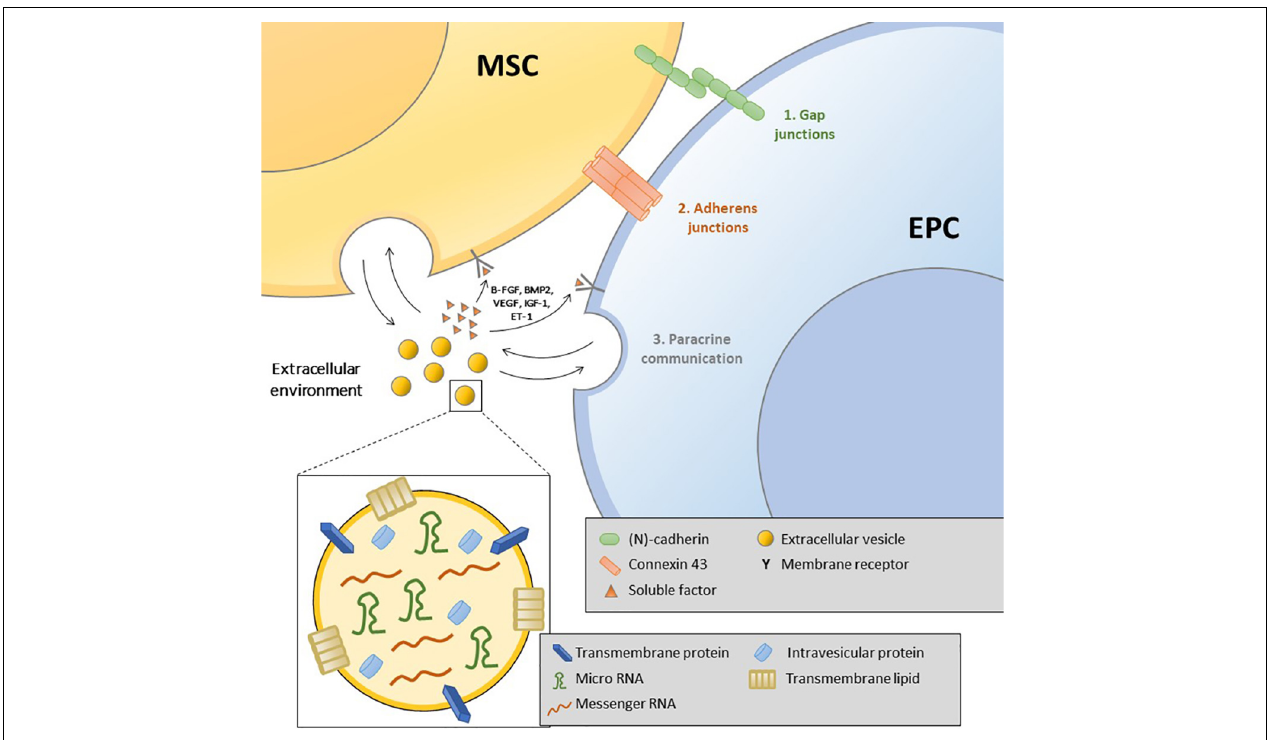
FIGURE 2 | Illustration of the different types of interaction between mesenchymal stromal cells and endothelial progenitor cells: gap junctions, adherence junctions, soluble factors, and extracellular